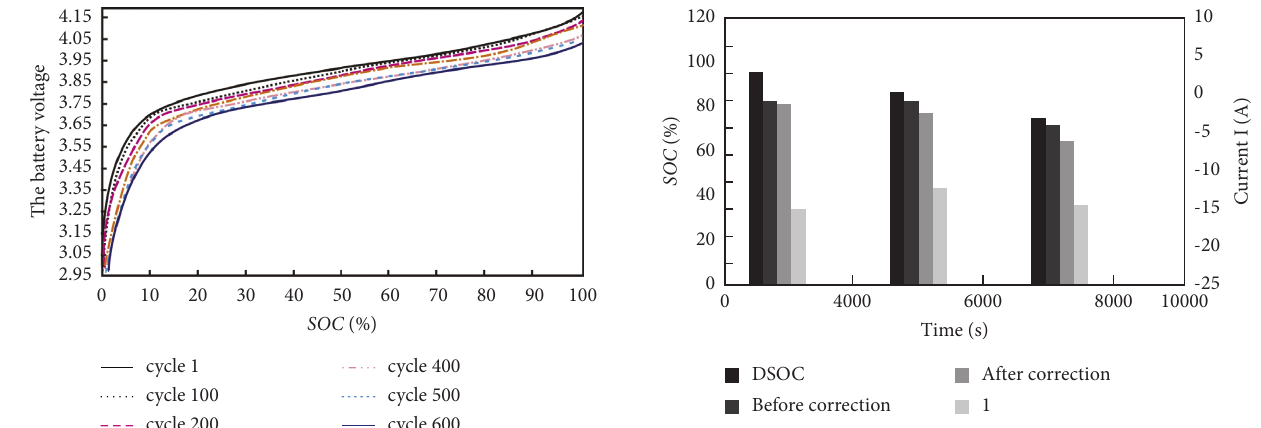
Figure 9: Comparison of SOC estimation before and after battery internal resistance